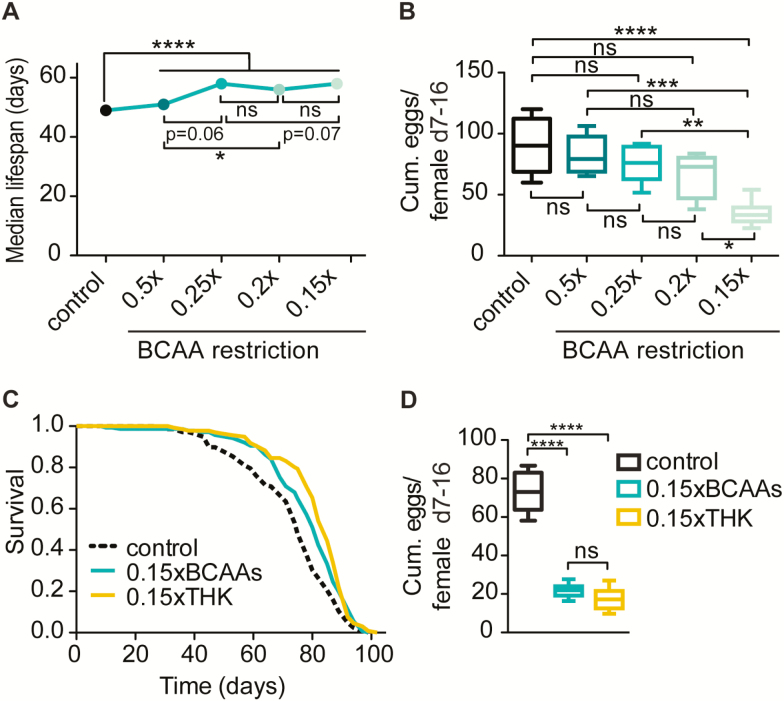
Restriction of branched-chain amino acids (BCAAs) extended fly lifespan and reduced fecundity to a similar degree as threonine, histidine and lysine (THK) restriction. (A) Restriction of BCAAs extended lifespan in a dose-dependent manner. Restricting BCAAs from 0.5xBCAAs to 0.25xBCAAs did not increase survival further, whereas decreasing it to 0.2xBCAAs and 0.15xBCAAs additionally extended lifespan. N = 200. Log-rank test. *p < .05, ****p < .0001. (B) BCAA restriction reduced cumulative egg-laying measured from Day 7–16 only when BCAAs were restricted to 0.15x of their concentration in the control diet. N = 6. One-way analysis of variance (ANOVA) followed by Bonferroni’s test. **p < .01, ***p < .001, ****p < .0001. (C) Restriction of BCAAs (p = .002) or THK (p = 8.35 × 10−07) extended lifespan to the same extent (p = .08). N = 200. Experiments were performed three times (Supplementary Figure S3). Log-rank test and Cox proportional hazard analysis (Supplementary Table S4A–C). (D) Restriction of BCAAs (p < .0001) or THK (p < .0001) reduced cumulative egg-laying measured from Day 7–14 to the same degree (p > .05). N = 10. One-way ANOVA followed by Bonferroni’s test.